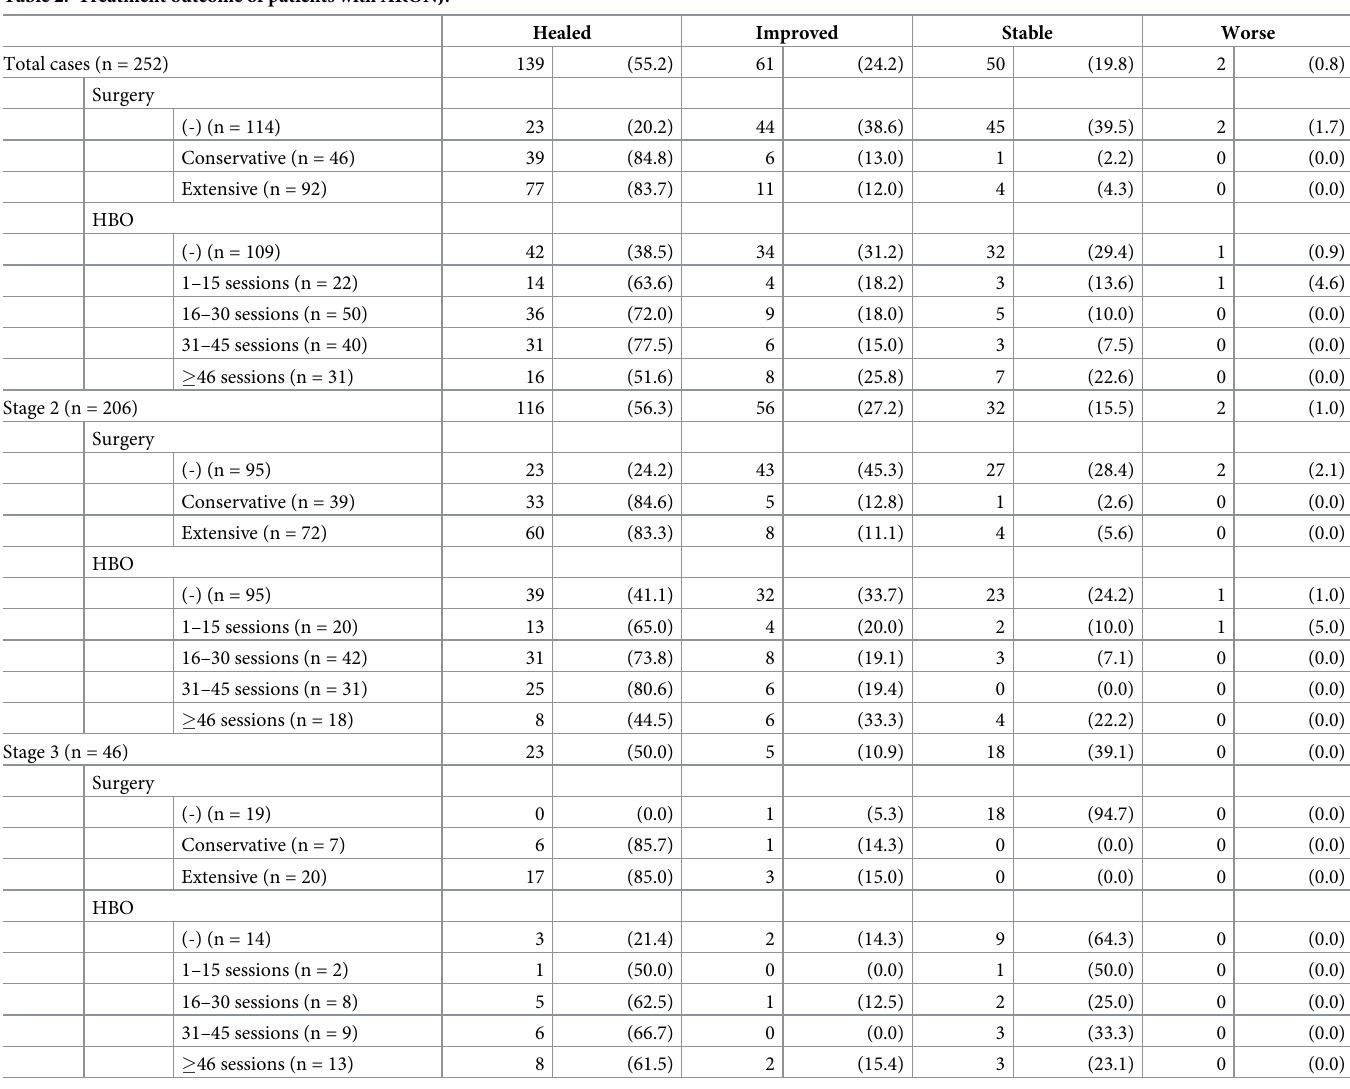
Table 2. Treatment outcome of patients with ARONJ.